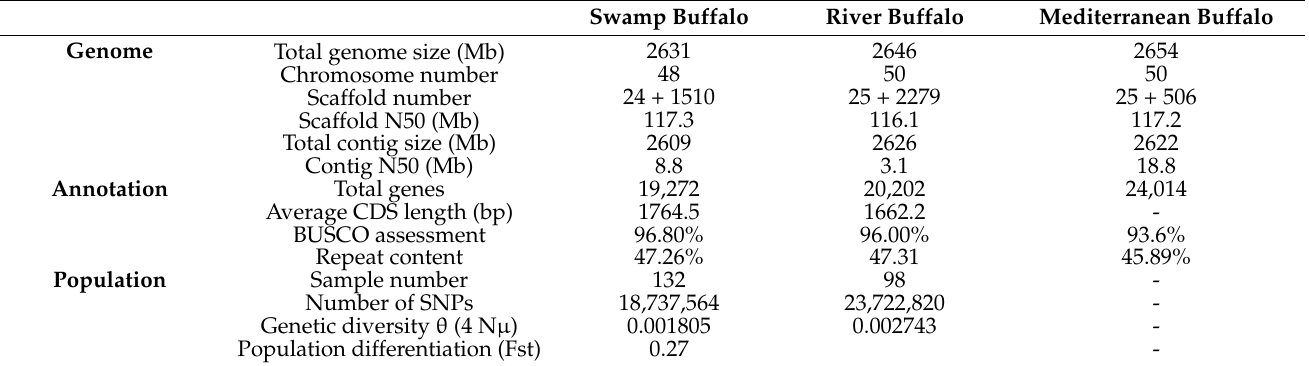
Table 1. Genome sequences statistics, annotation, and population parameters.